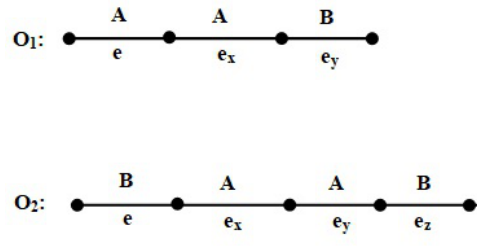
Figure 8. Edge status of A, B and the two Operations